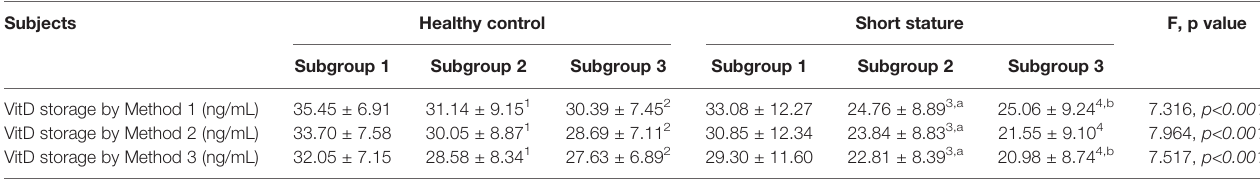
TABLE 3 | Evaluation of vitamin D storage in subjects.